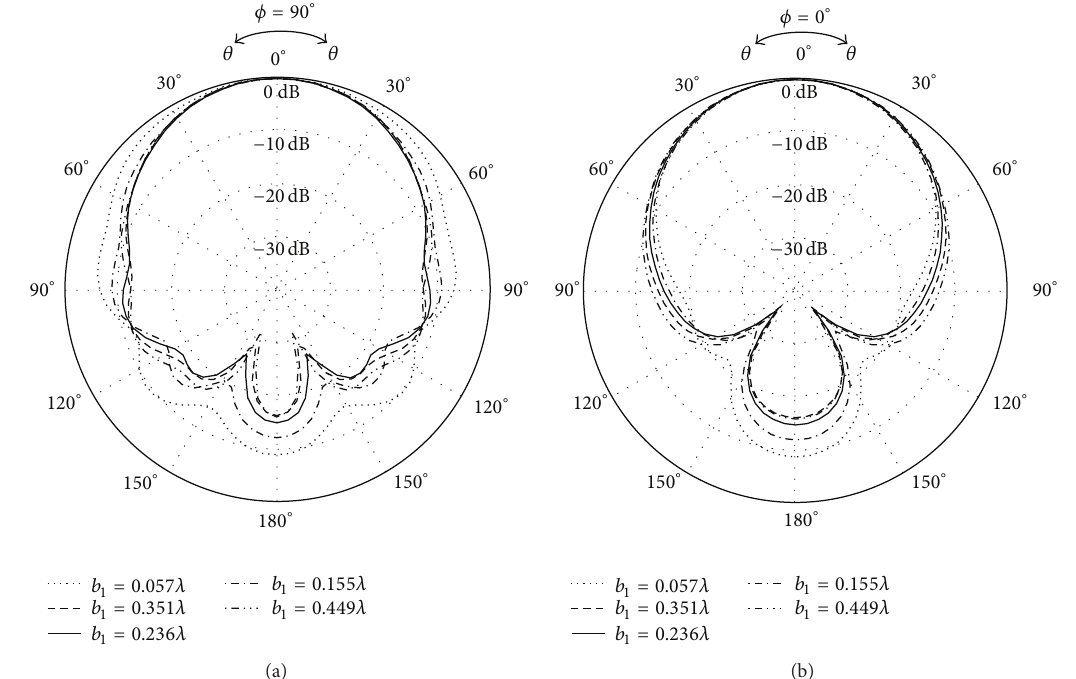
Figure 15: Simulated radiation patterns for various parasitic coupling aperture heights ( 𝑏 1 ) at the upper frequency of 2.484 GHz in (a) the 𝐸 -plane and (b) the 𝐻